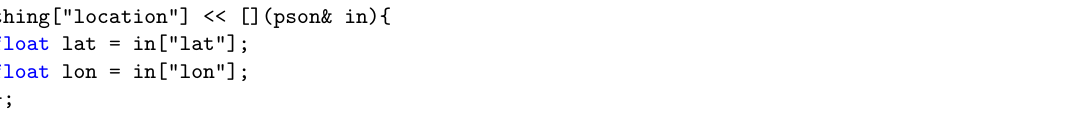
Figure 12. Pass multiple